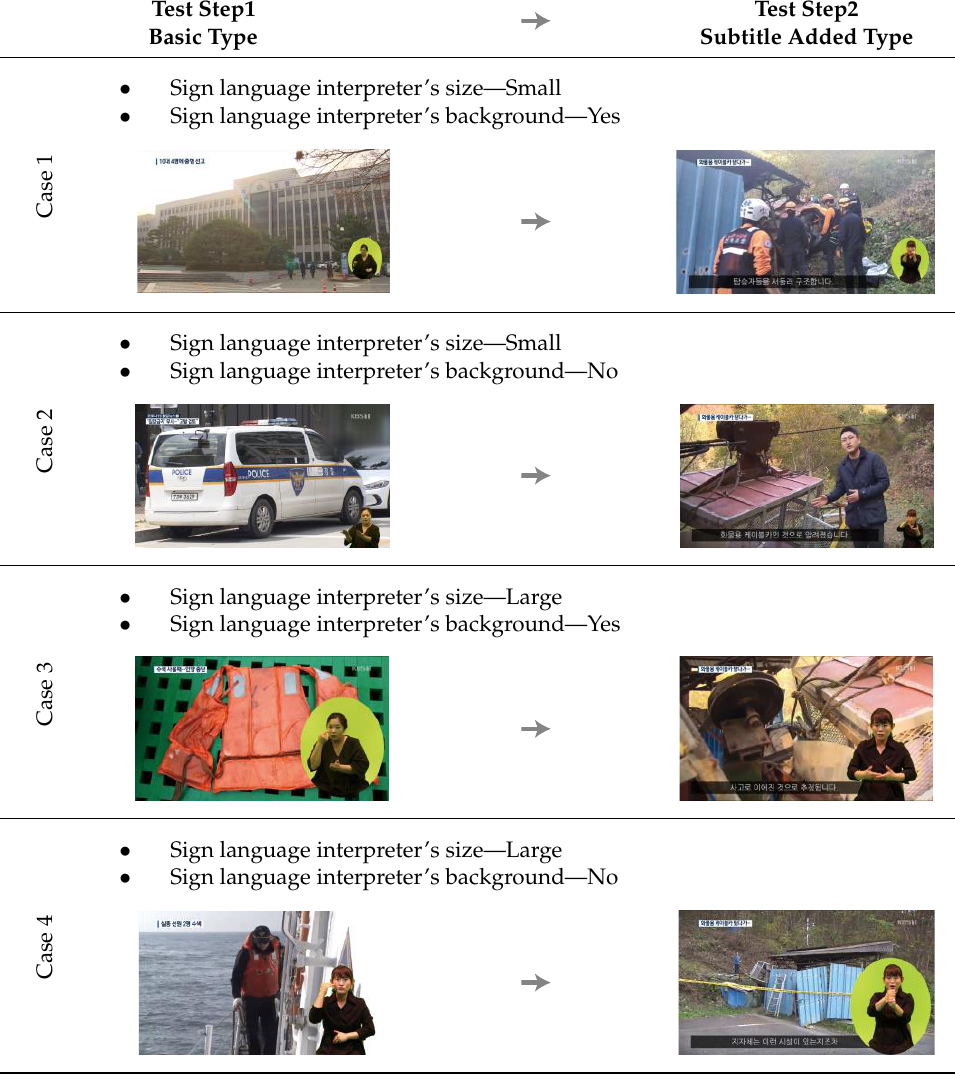
Table 2. Experiment design for news.